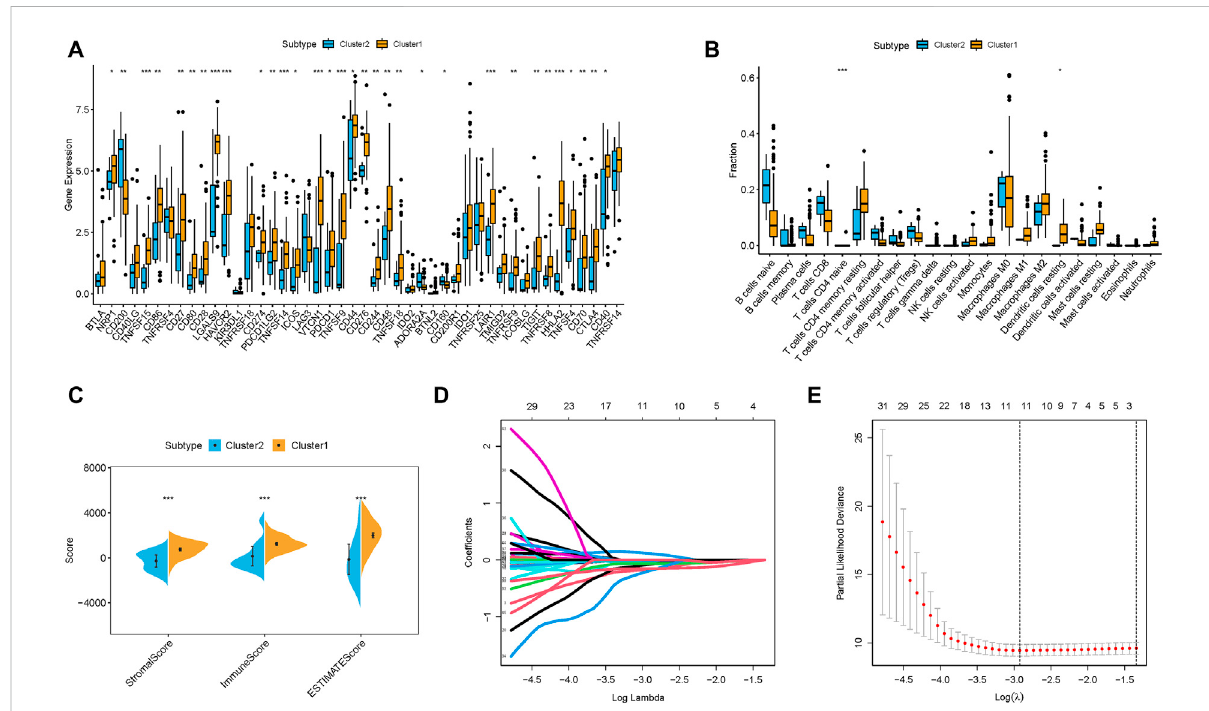
FIGURE 5 TIME contexture of m6A clusters in PDAC. (A) Differentially expression analysis of immune checkpoint blockade genes in m6A clusters. The fractionoftumor-in fi ltratinglymphocytecellsinm6Aclusters.Withineachgroup,thescattereddotsrepresentTIMEcellexpressionvalues.Thethick linerepresentsthemedianvalue.Thebottomandtopoftheboxesarethe25thand75thpercentiles(interquartilerange).Thewhiskersencompassed 1.5 times the interquartile range. The statistical difference of three gene clusters was compared through the Kruskal – Wallis H test. * p < 0.05; ** p < 0.01; *** p < 0.001. (B) CIBERSORT algorithm; (C) ESTIMATE approach. Identi fi cation of the candidate stemness-related genes with prognostic value. (D) LASSO coef fi cient pro fi les of the expression of 45 candidate m6A-related lncRNAs. (E) Selection of the penalty parameter ( λ ) in the LASSO model via 10-fold cross-validation. The dotted vertical lines are plotted at the optimal values following the minimum criteria (left) and “ one standard error ” criteria